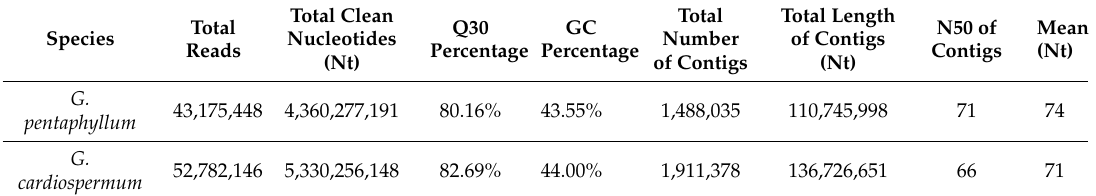
Table 1. Transcriptome reads and assembled contigs information for two Gynostemma species.